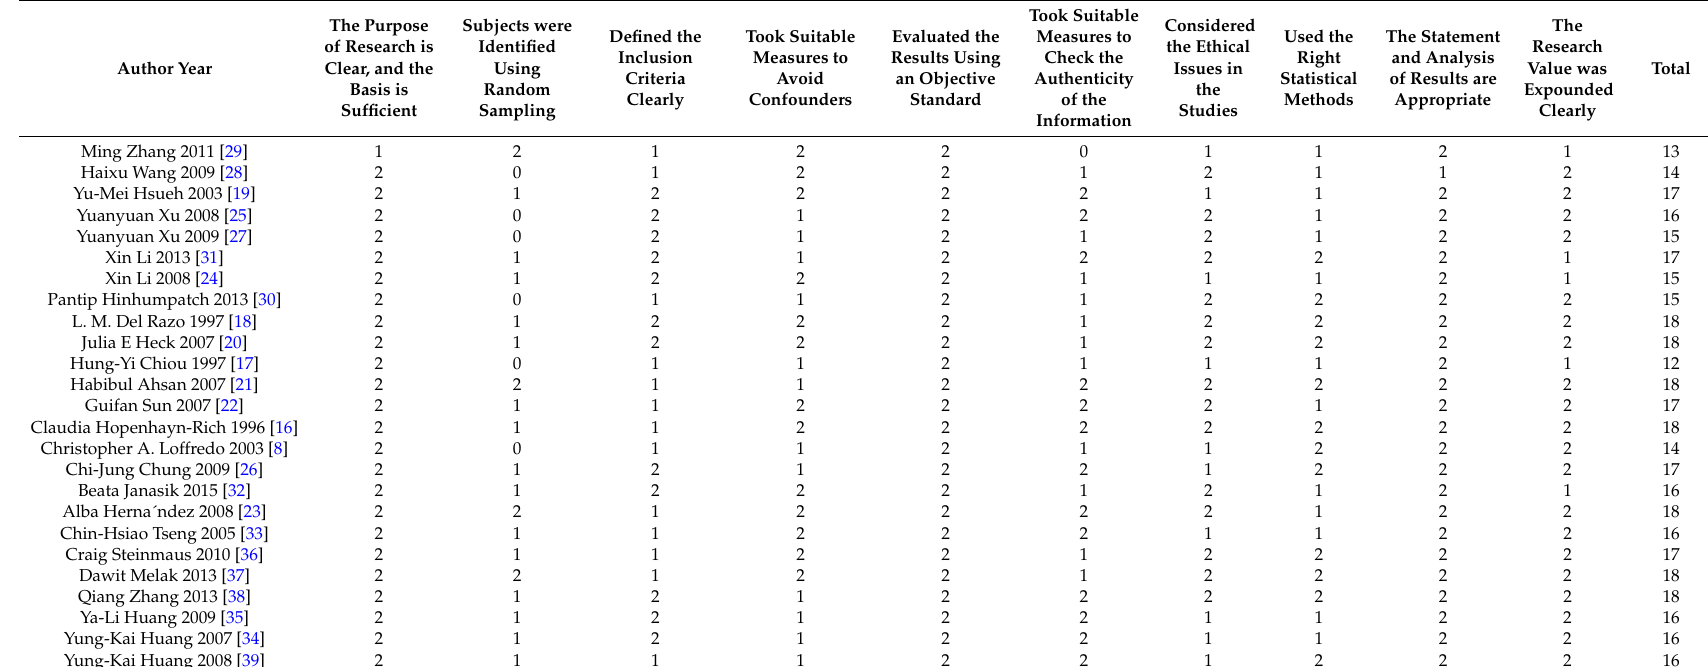
Table 1. Quality of the included studies, asevaluated using the Joanna Briggs Institute